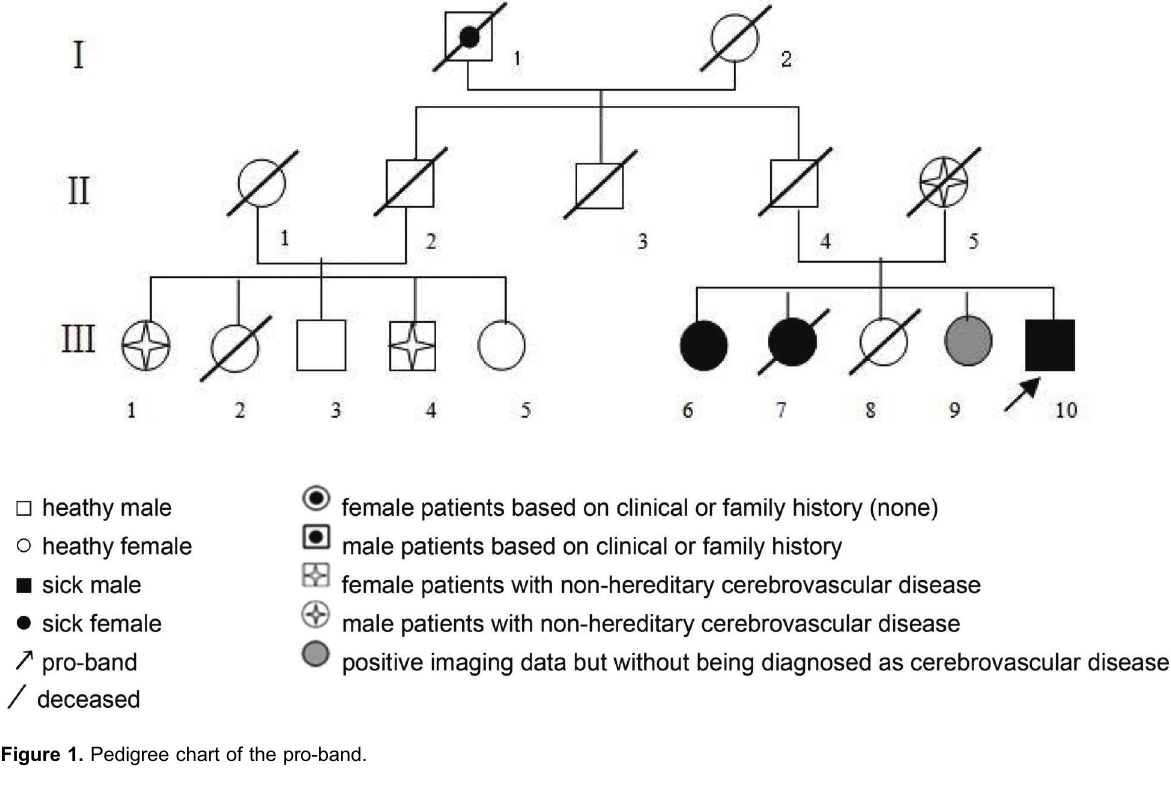
Figure 1. Pedigree chart of the pro-band.